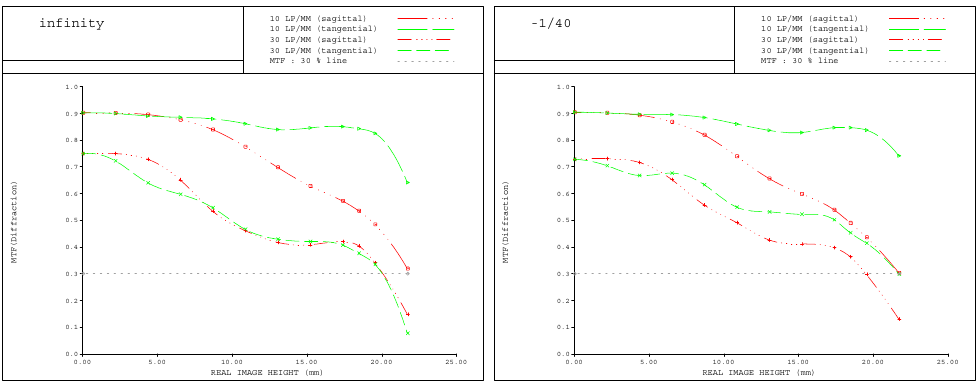
Figure 11. Image heights vs. MTF plots of the final designs at the infinite and main imaging distance.